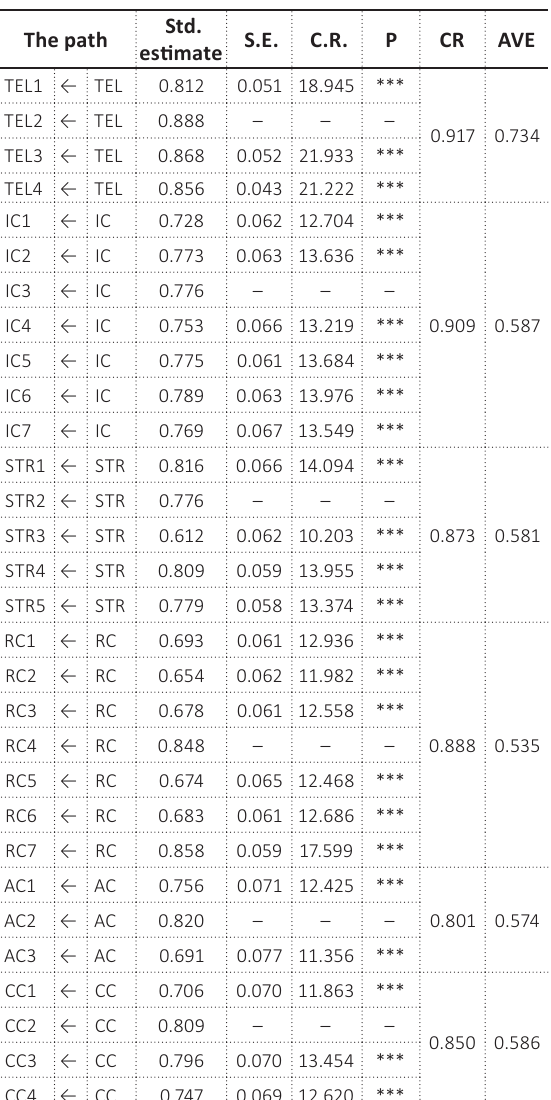
Table 5. Results of the confirmatory factor